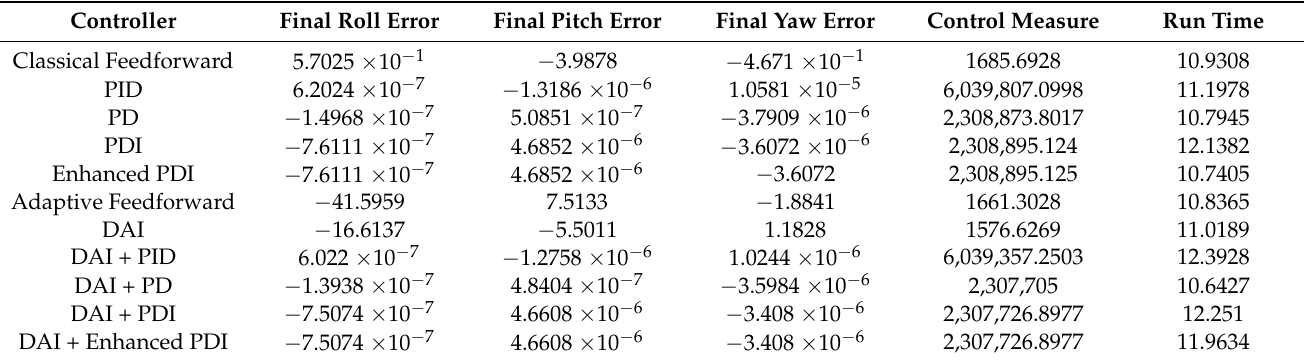
Table 4. System responses for various controller architectures in response to Pontryagin derived trajectory for a non-symmetric spacecraft.